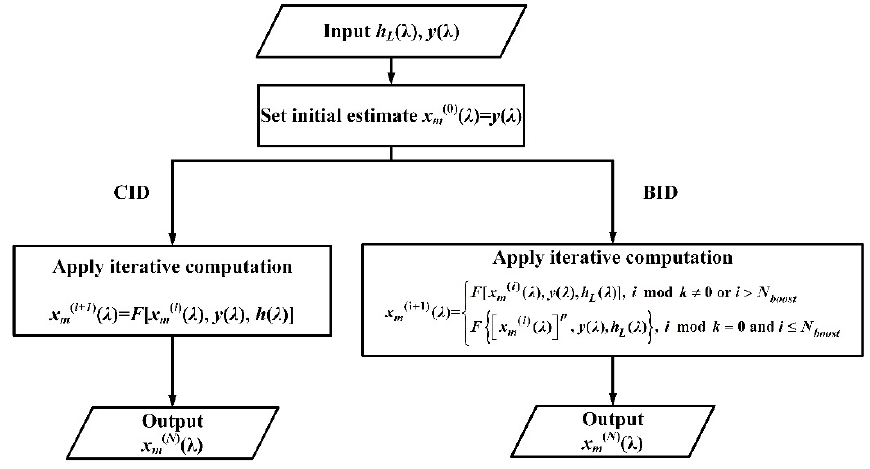
Figure 4. Flowchart of BID and CID.